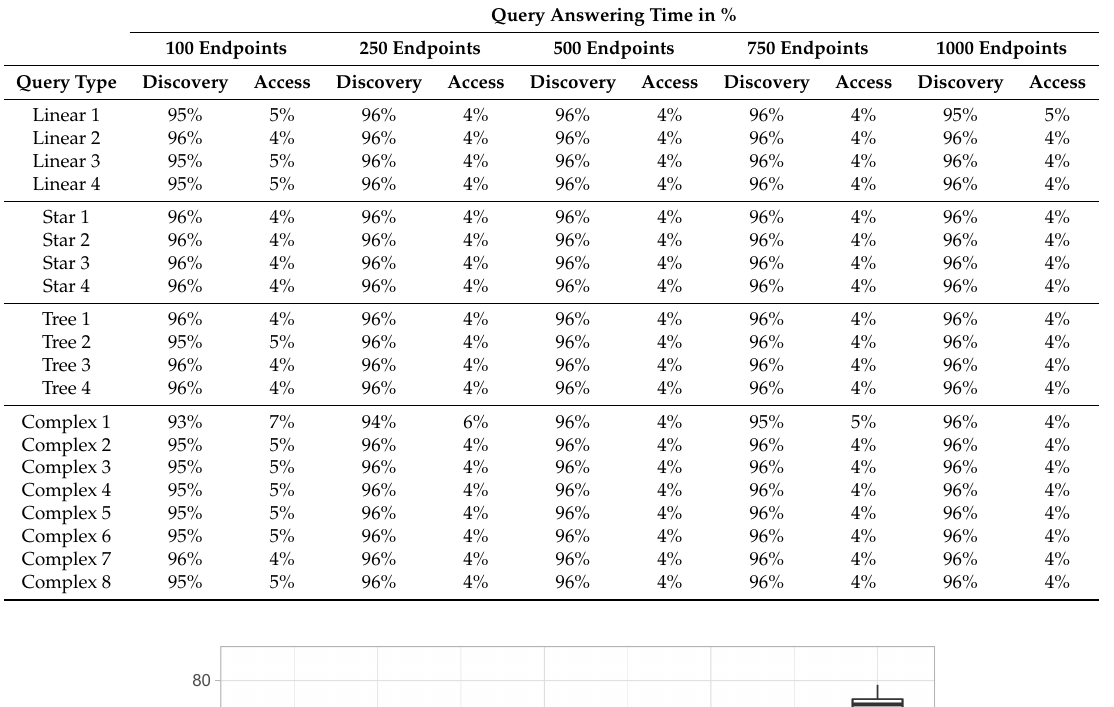
Table 3. Percentage of Discovery time and Distributed Access plus Translation time. Query Answering Time in % 100 Endpoints 250 Endpoints